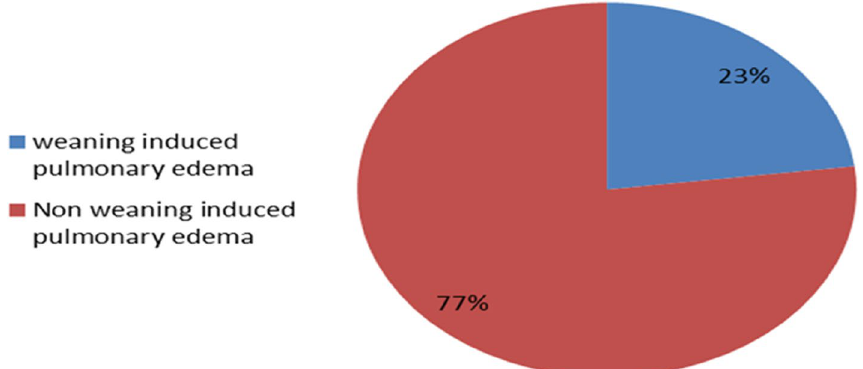
Fig. 1 Frequency of confirmed diagnosis of weaning‑induced pulmonary edema (WIPE)